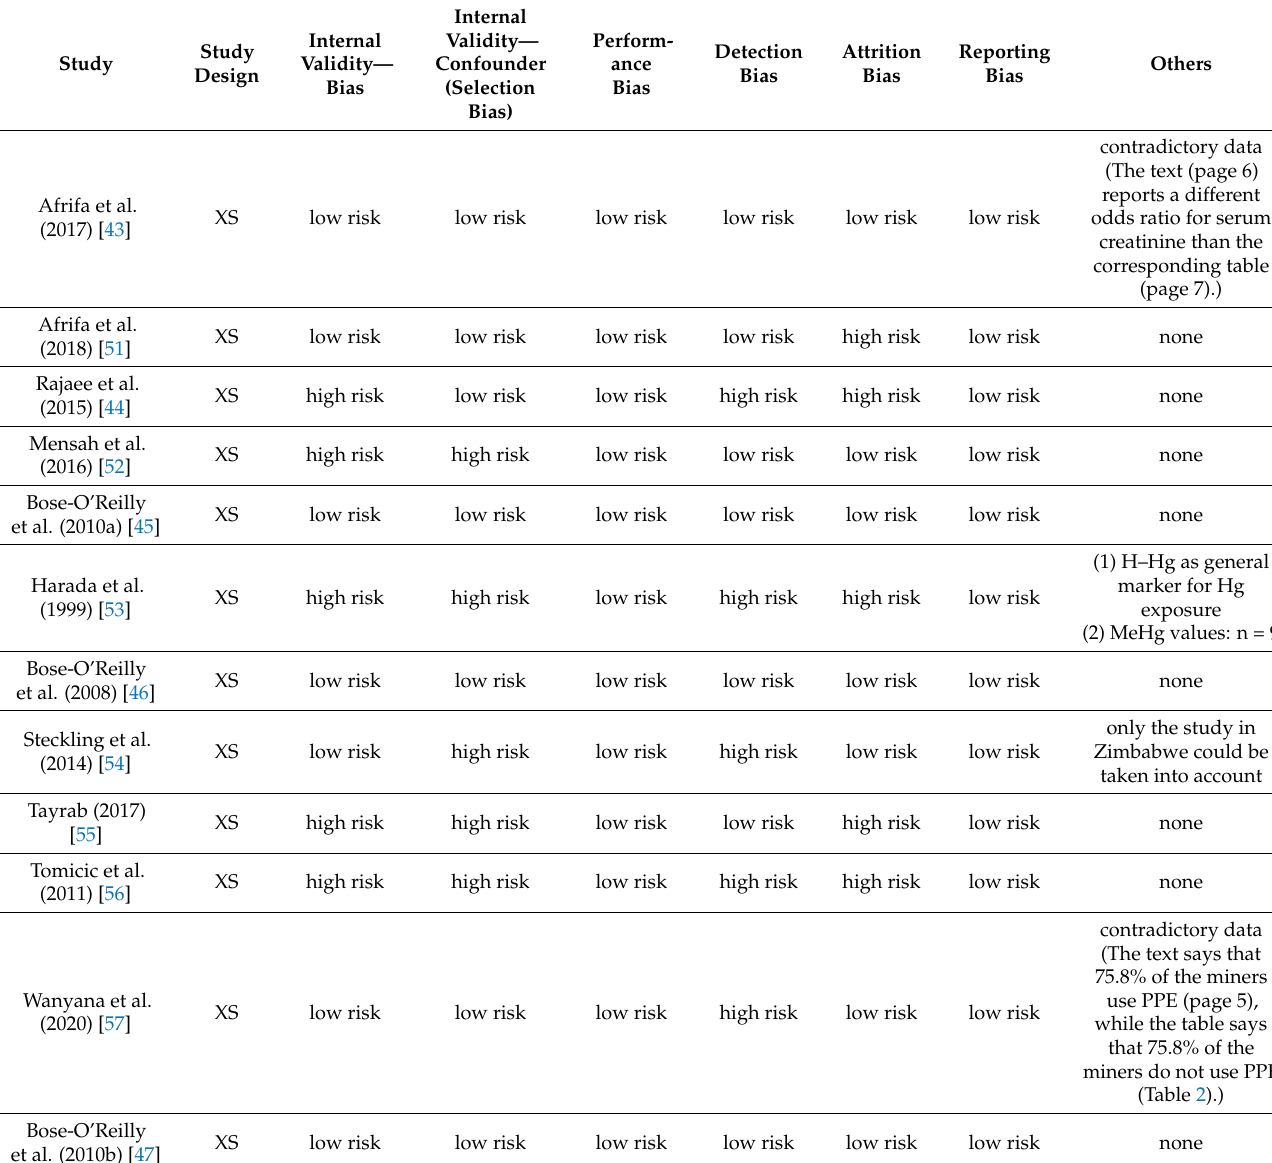
Table 3. Bias assessment. (XS: cross sectional